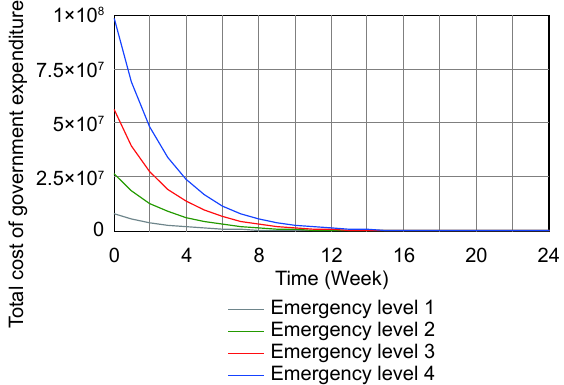
Fig. 6 Total cost of government expenditure under different emergency